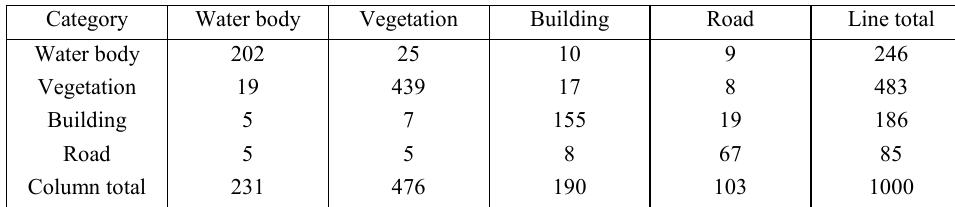
Table 2. SVM classification obfuscation matrix